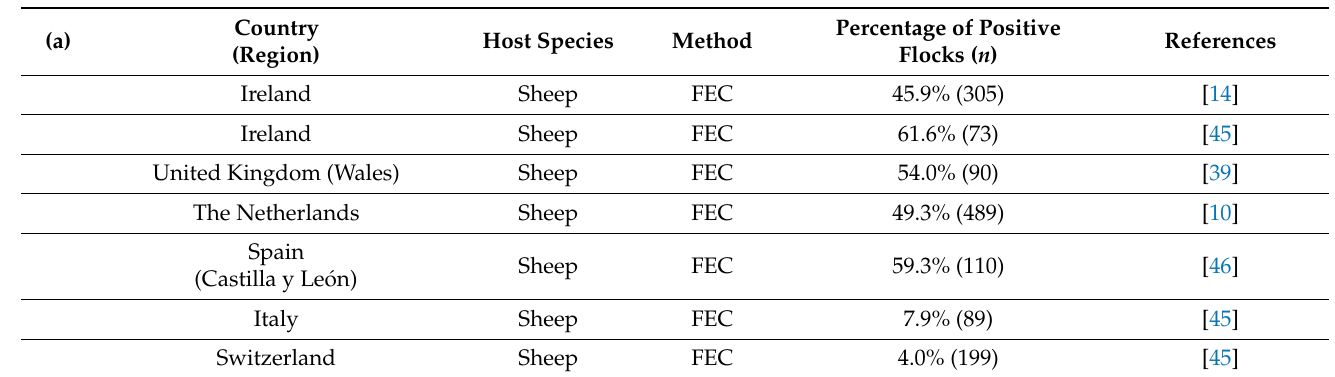
Table 2. Reported occurrence of F. hepatica infections in small ruminants in Europe specifying the number of flocks ( a ) or number of individual animals ( b ) examined, as well as the diagnostic methods